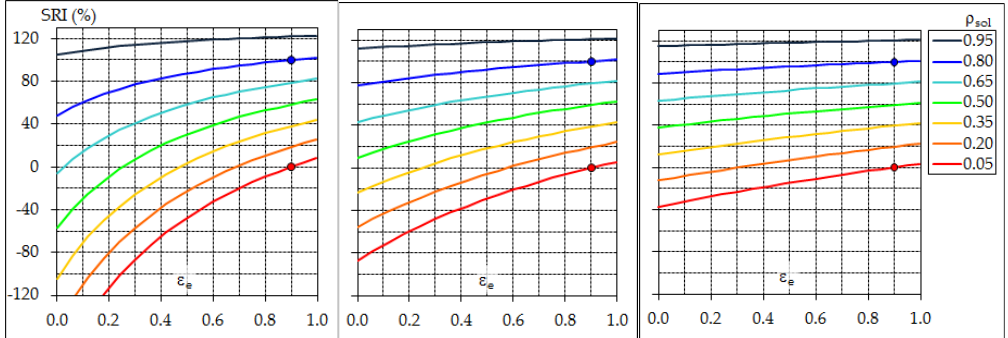
Figure 2. Solar reflectance index (SRI) for reference ambient conditions and (from left to right) low (v wind < 2 m/s, h ce = 5 W/(m 2 K)), intermediate (2 m/s < v wind < 6 m/s, h ce = 12 W/(m 2 K)), and high (6 m/s < v wind < 10 m/s, h ce = 30 W/(m 2 K)) wind speed; blue and red dots are for the reference white and black surfaces, respectively.